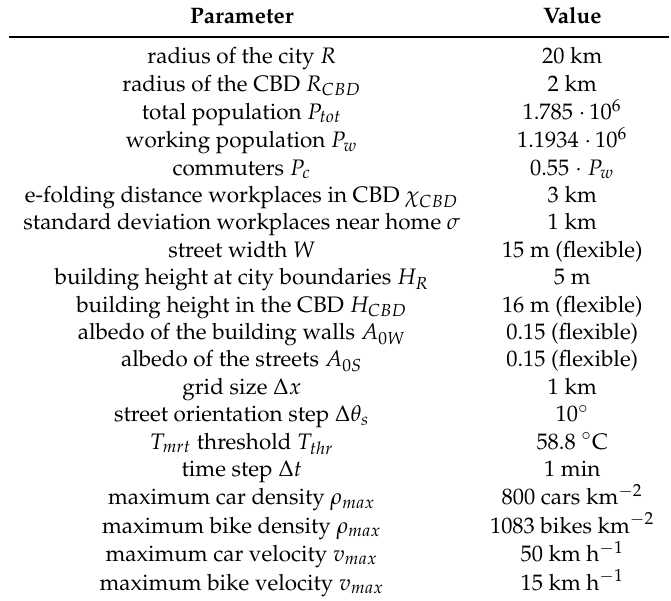
Table 1. List of parameters for city properties, T mrt module and traffic model. Parameters that are varied in this study are indicated as